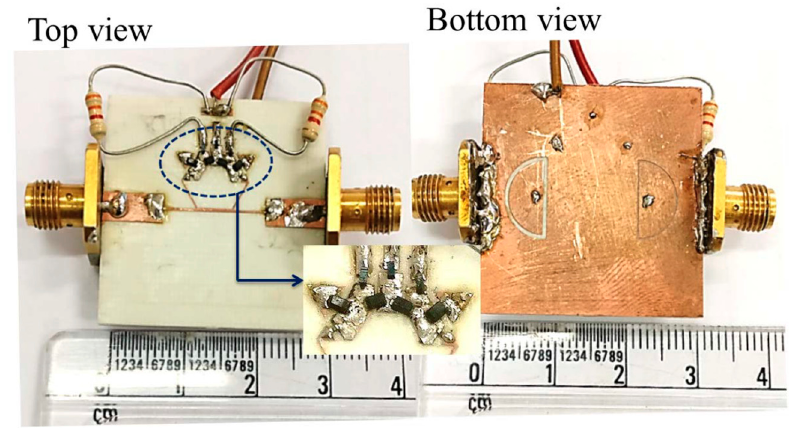
Figure 13. The tuneable microstrip LPF [62].